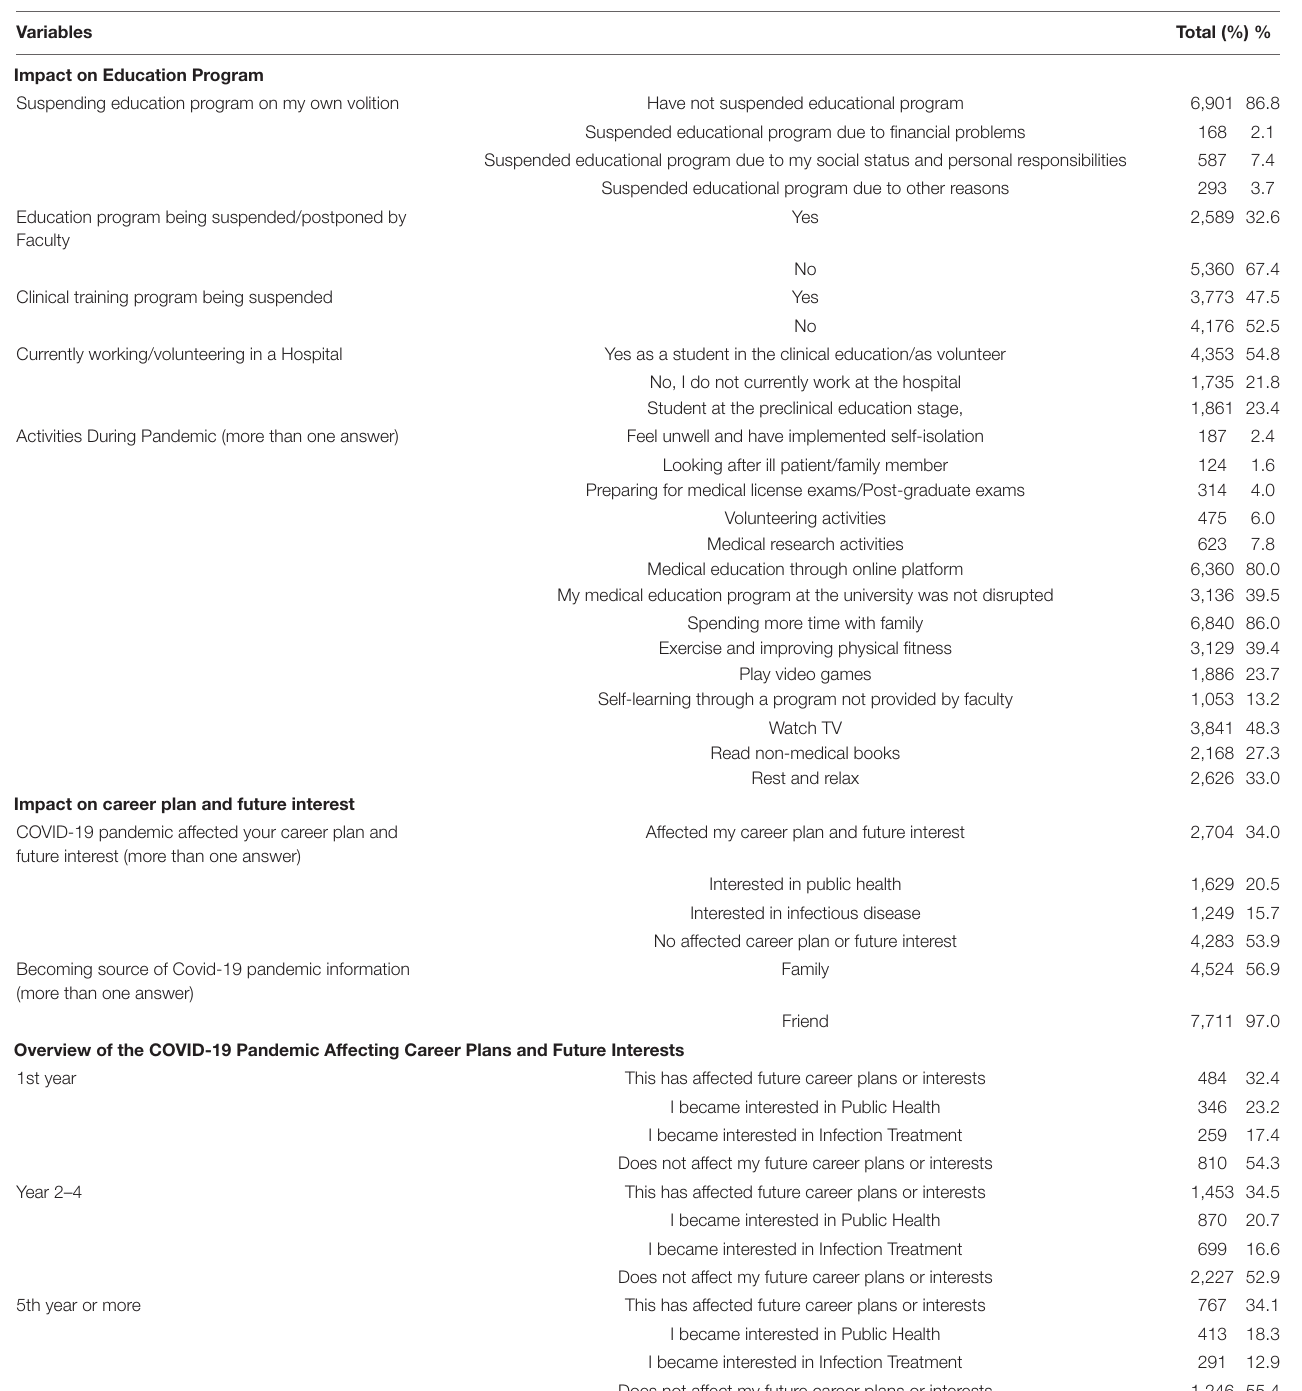
TABLE 3 | Pandemic impact on education